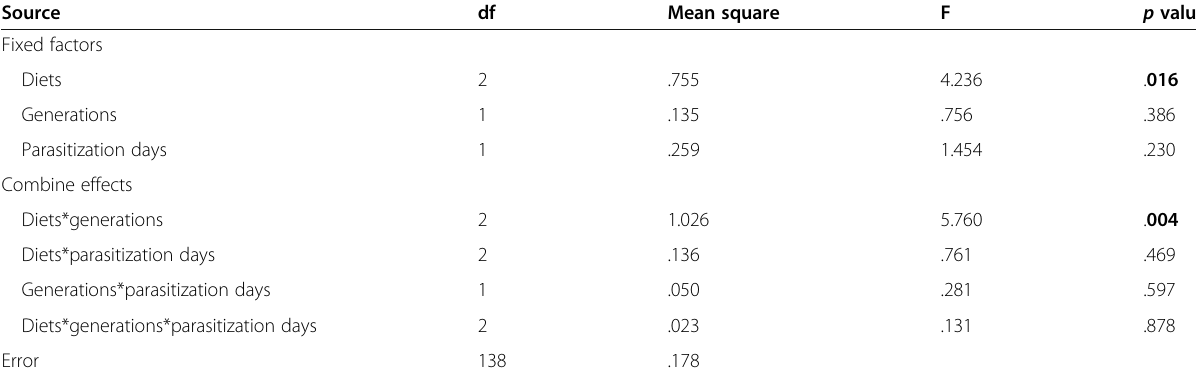
Table 3 Generalized linear model (GLM) analysis for the development of Trichogramma evanescens on host eggs reared from different diets